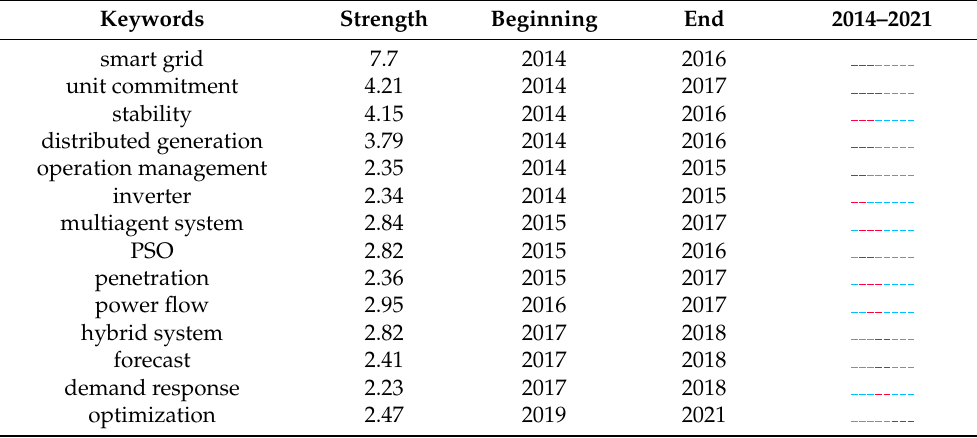
opposite the opposite situation.